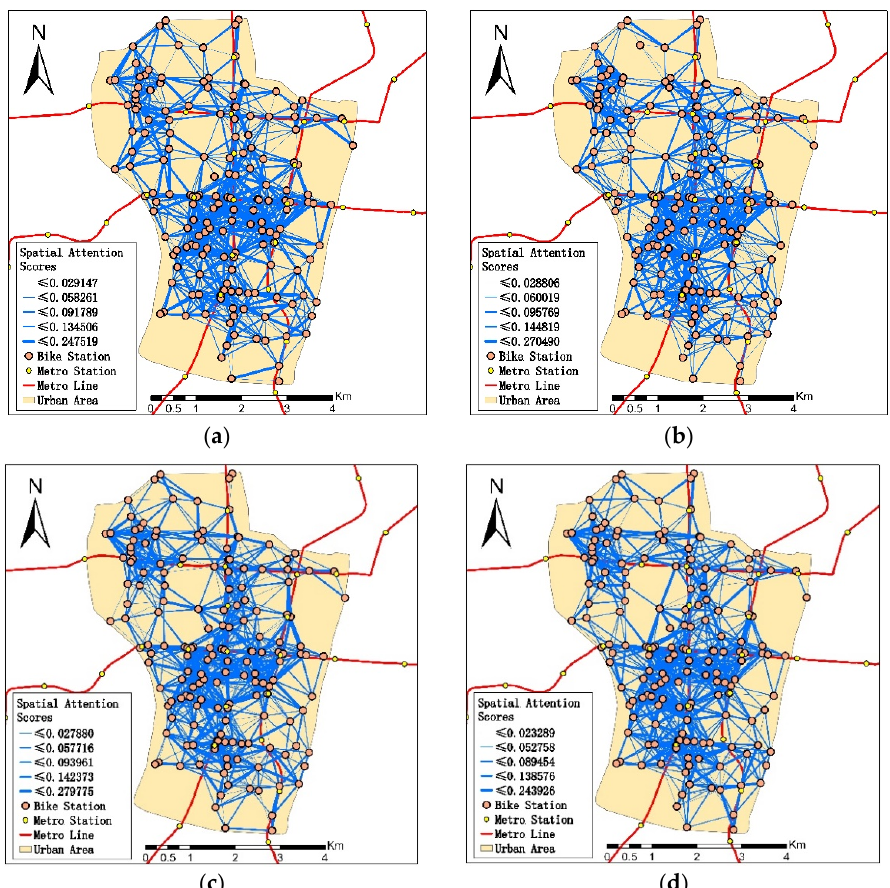
Figure 7. Spatial attention score among stations of the different prediction horizons. ( a ) 15-min horizon; ( b ) 30-min horizon; ( c ) 45-min horizon; ( d ) 60-min horizon. horizon; ( b ) 30-min horizon; ( c ) 45-min horizon; ( d ) 60-min